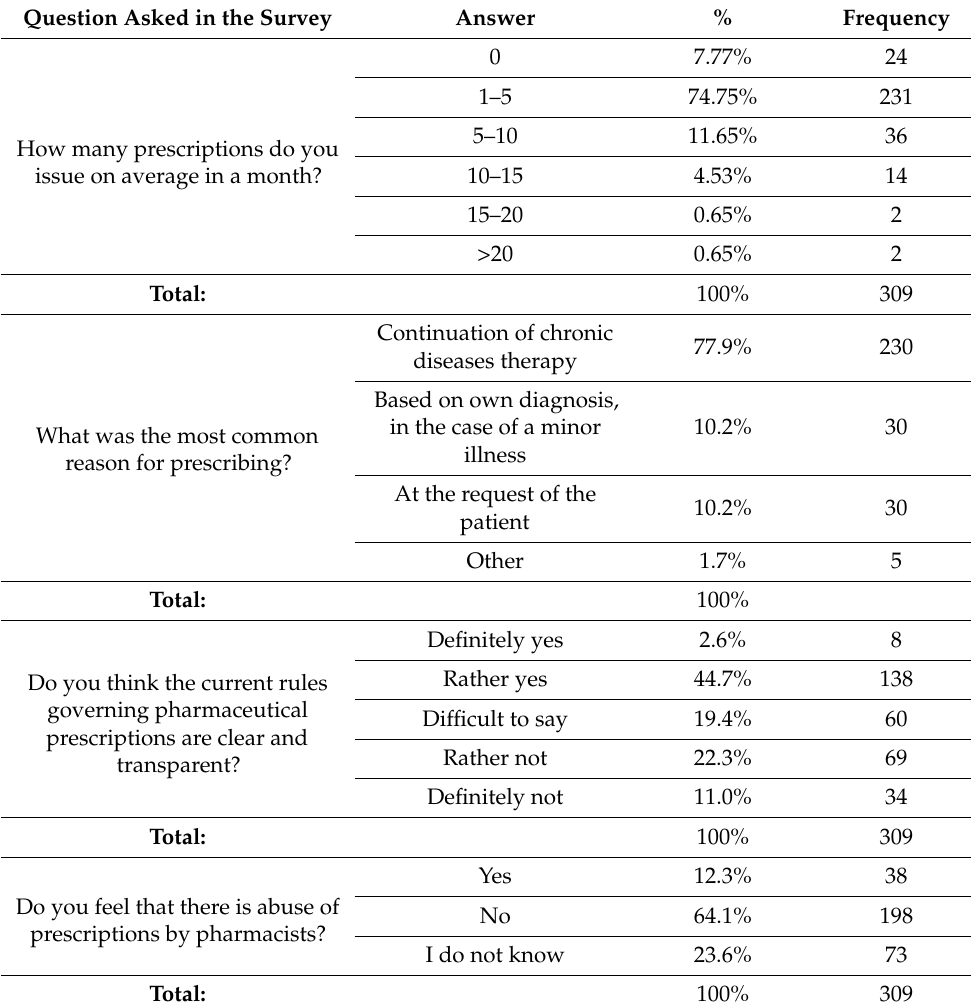
Table 3. Distribution of respondents’ responses to questions about opinions and experiences with